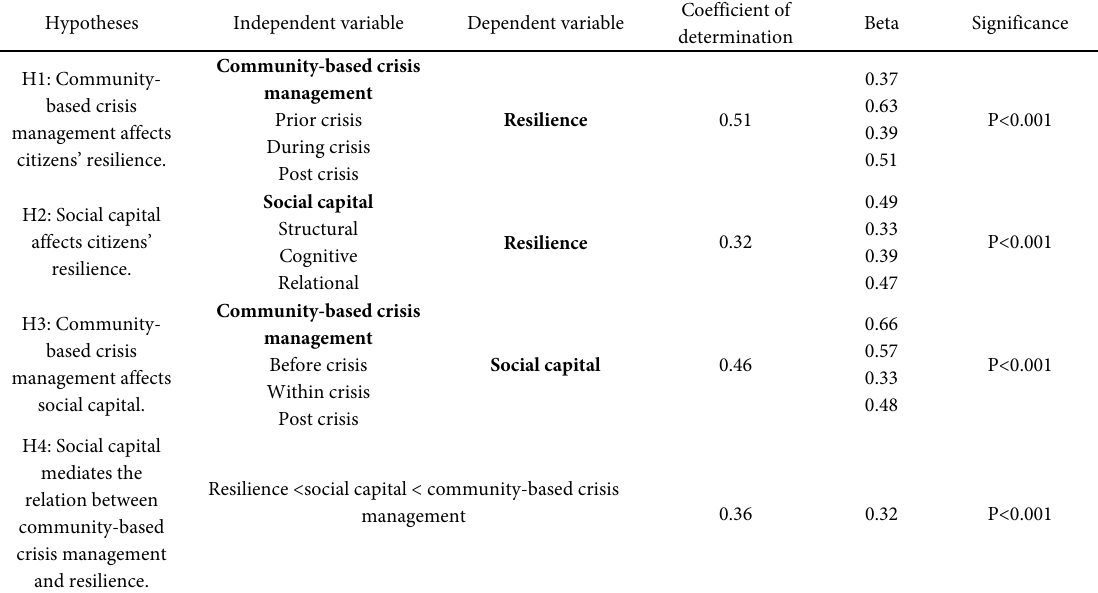
Table 3: Research hypotheses test results